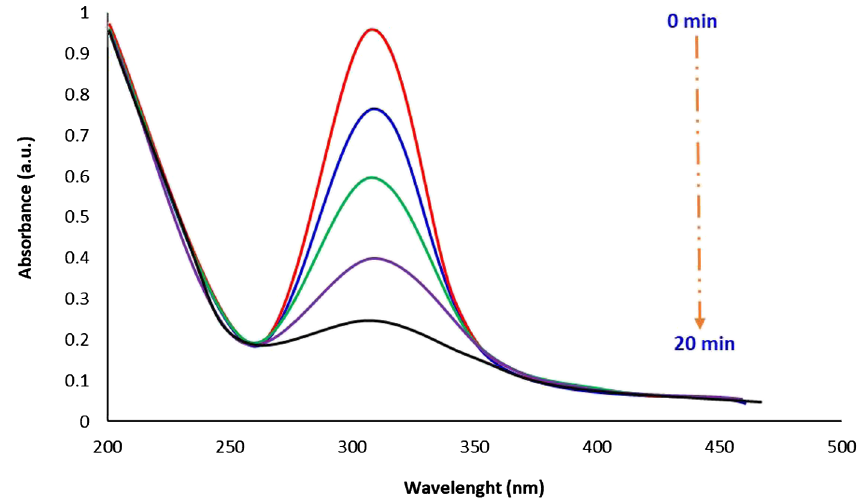
Figure 6: UV-Vis absorption spectral changes during absorption of 4-nitrophenol solution at different times using green CuO NPs.